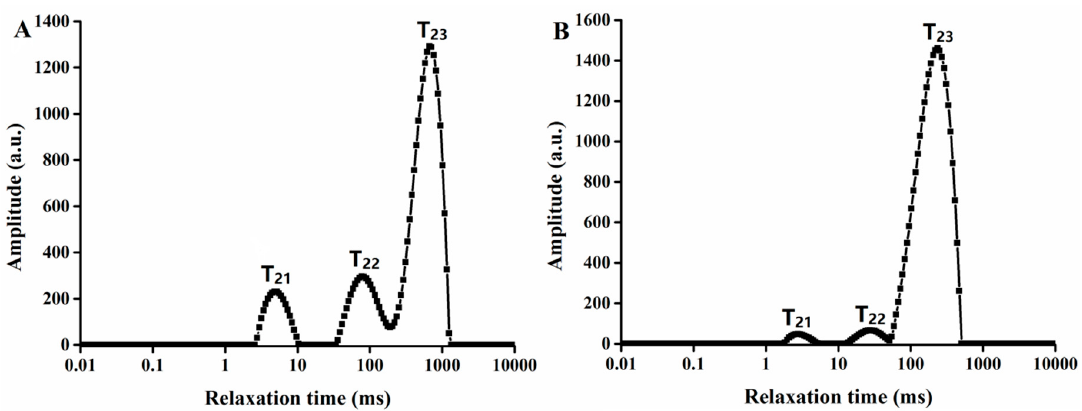
Figure 1. LF-NMR T 2 relaxation time distribution curves of G. elata ( A ) before steaming and ( B ) after steaming.